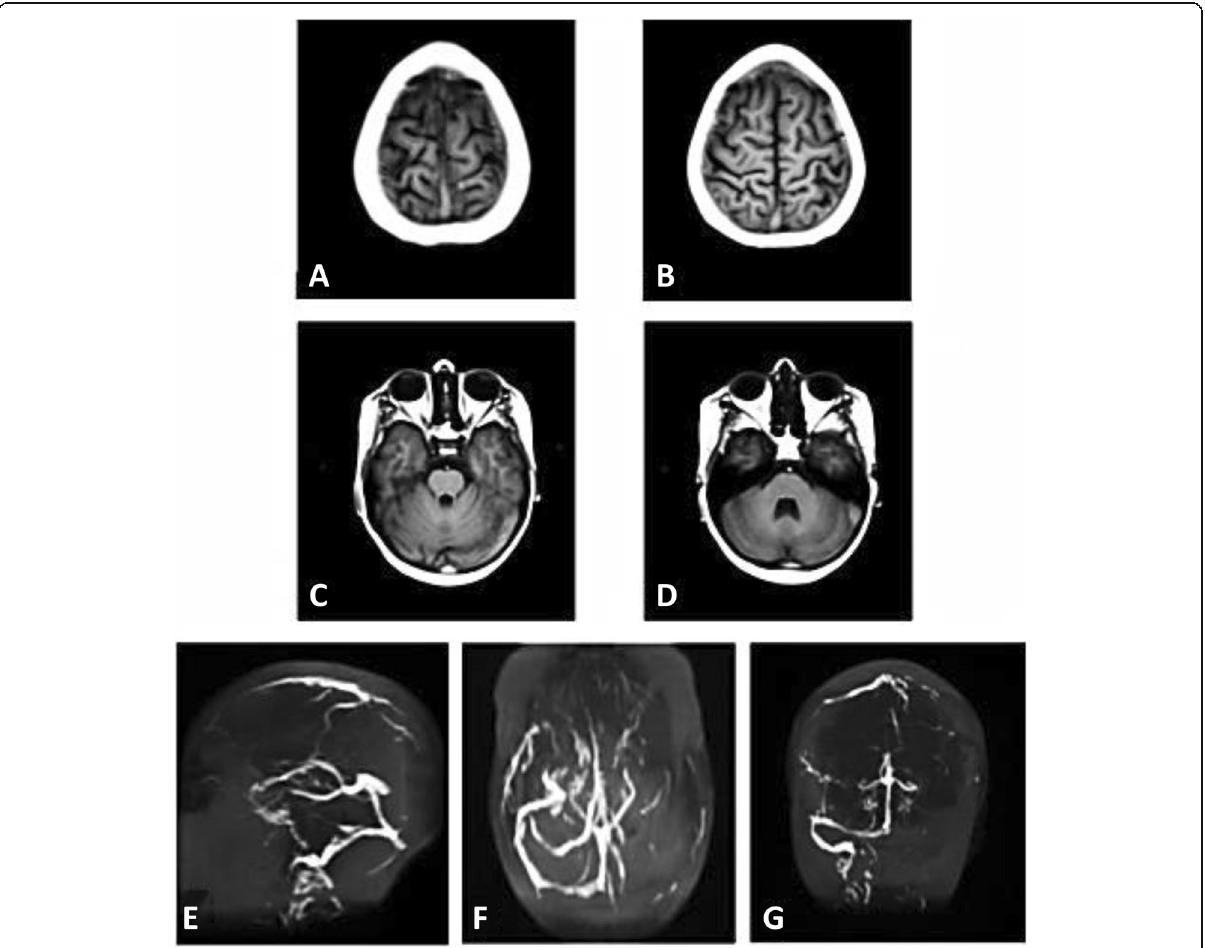
Fig. 7 Superior sagittal sinus and left transverse sinus thrombosis. Female patient, 7 years old, treated for ALL at the maintenance phase, on L- asparaginase treatment presented with severe headache. a – d Axial MRI of the brain. a , b Axial T1WI at the level of frontal lobes revealed acute thrombus filling the superior sagittal sinus. c , d Images axial T1WI of the same patient at the level of posterior fossa shows acute thrombus filling left transverse and left sigmoid sinuses eliciting bright signal in T1WI. e – g MIP images of MRV, sagittal ( e ), axial ( f ), and coronal ( g ) of the same patient show thrombosis of the posterior aspect of superior sagittal sinus, left transverse and left sigmoid